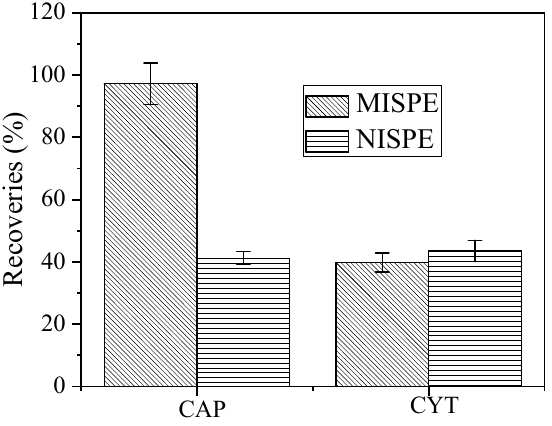
Figure 11. Recoveries of CAP and CYT on MISPE and NISPE cartridges .